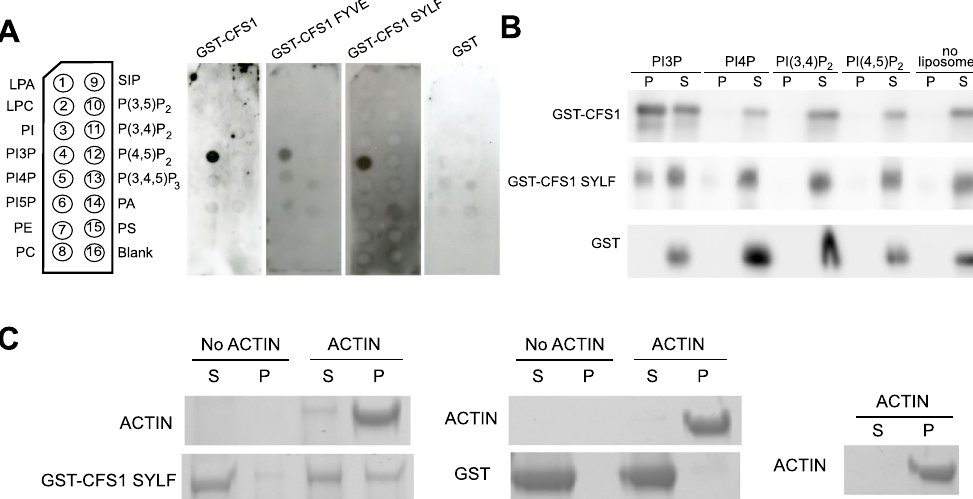
Figure 5. CFS1 is a PI3P- and actin-binding protein. ( A ) Lipid overlays dot blots showing that CFS1, its FYVE and SYLF domain specifically bind to PI3P. GST was used as a negative control. All stripes have the arrangement of lipid species shown on the left diagram. ( B ) Liposome sedimentation assays analyzed by SDS-PAGE and Coomassie staining show binding of CFS1 and its SYLF domain to PI3P. Liposomes contained PC/PE and 10% of the respective lipid species. GST and assays without liposomes were used as negative controls (P: pellet, S supernatant). Full-length blots are presented in Supplementary Figure S15. ( C ) Actin coesdimentation assays analyzed by SDS-PAGE and Coomassie staining show binding of GST-CFS1 SYLF domain to actin (P: pellet, S: Supernatant). Full-length gel is presented in Supplementary Figure